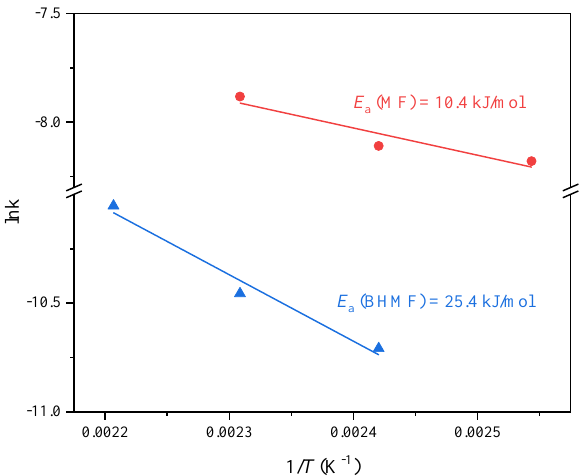
Figure 7. Profiles of Arrhenius plots of different intermediates in the selective hydrogenolysis of HMF over 0.5% Pt-2% FeO x /AC.